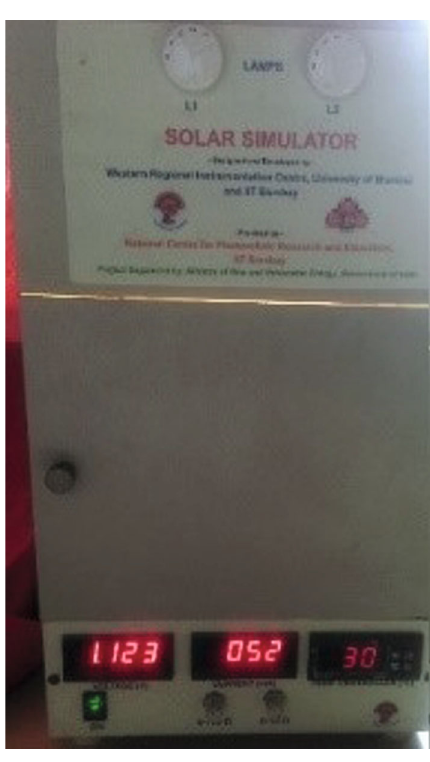
Figure 8: Solar PV